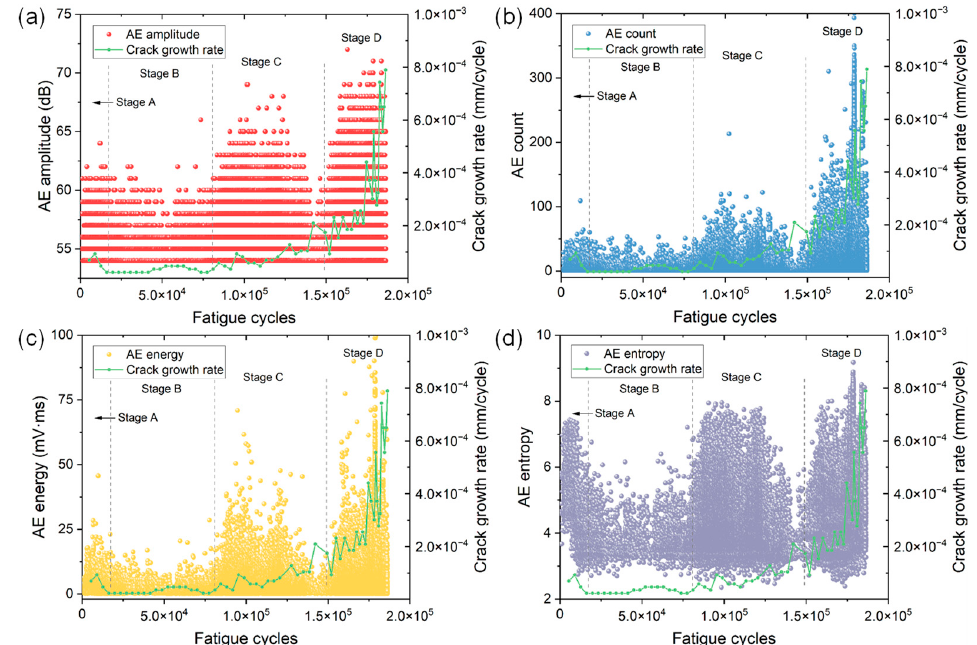
Figure 4. The variations of ( a ) amplitude, ( b ) count, ( c ) energy and ( d ) entropy versus fatigue cycles of specimen No. 1. The change in crack growth rate is also included for understanding the AE behaviors in different stages.